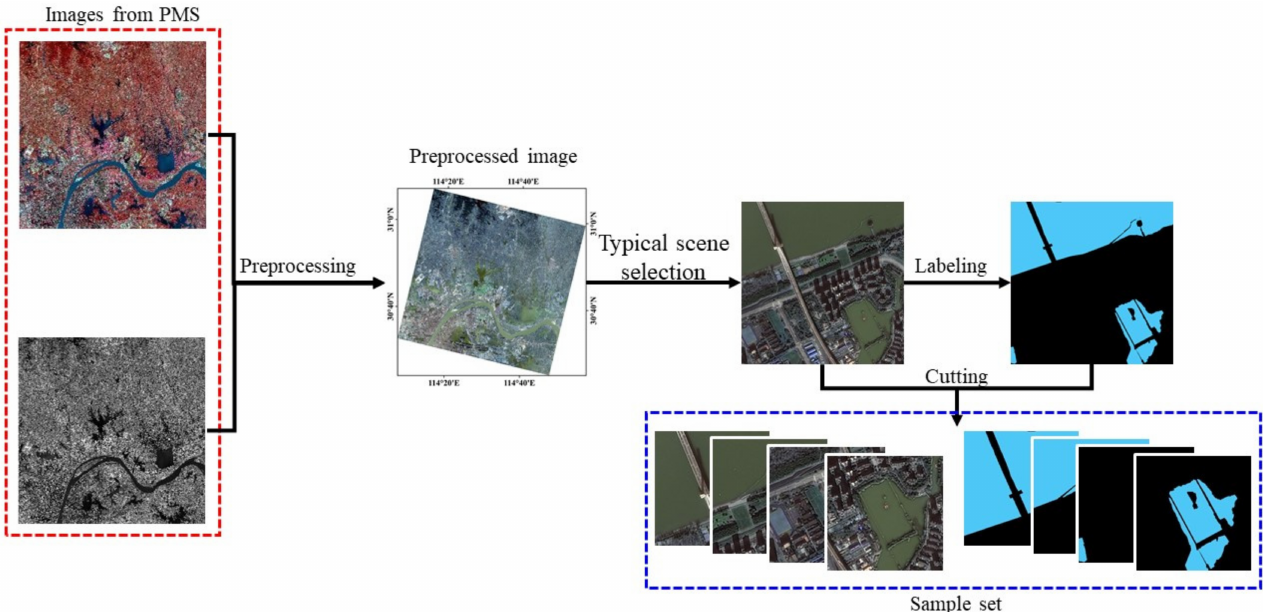
Figure 1. The study area and the GaoFen-1 D dataset (A, B, C, D, E, and G are used for training and F is used for testing).